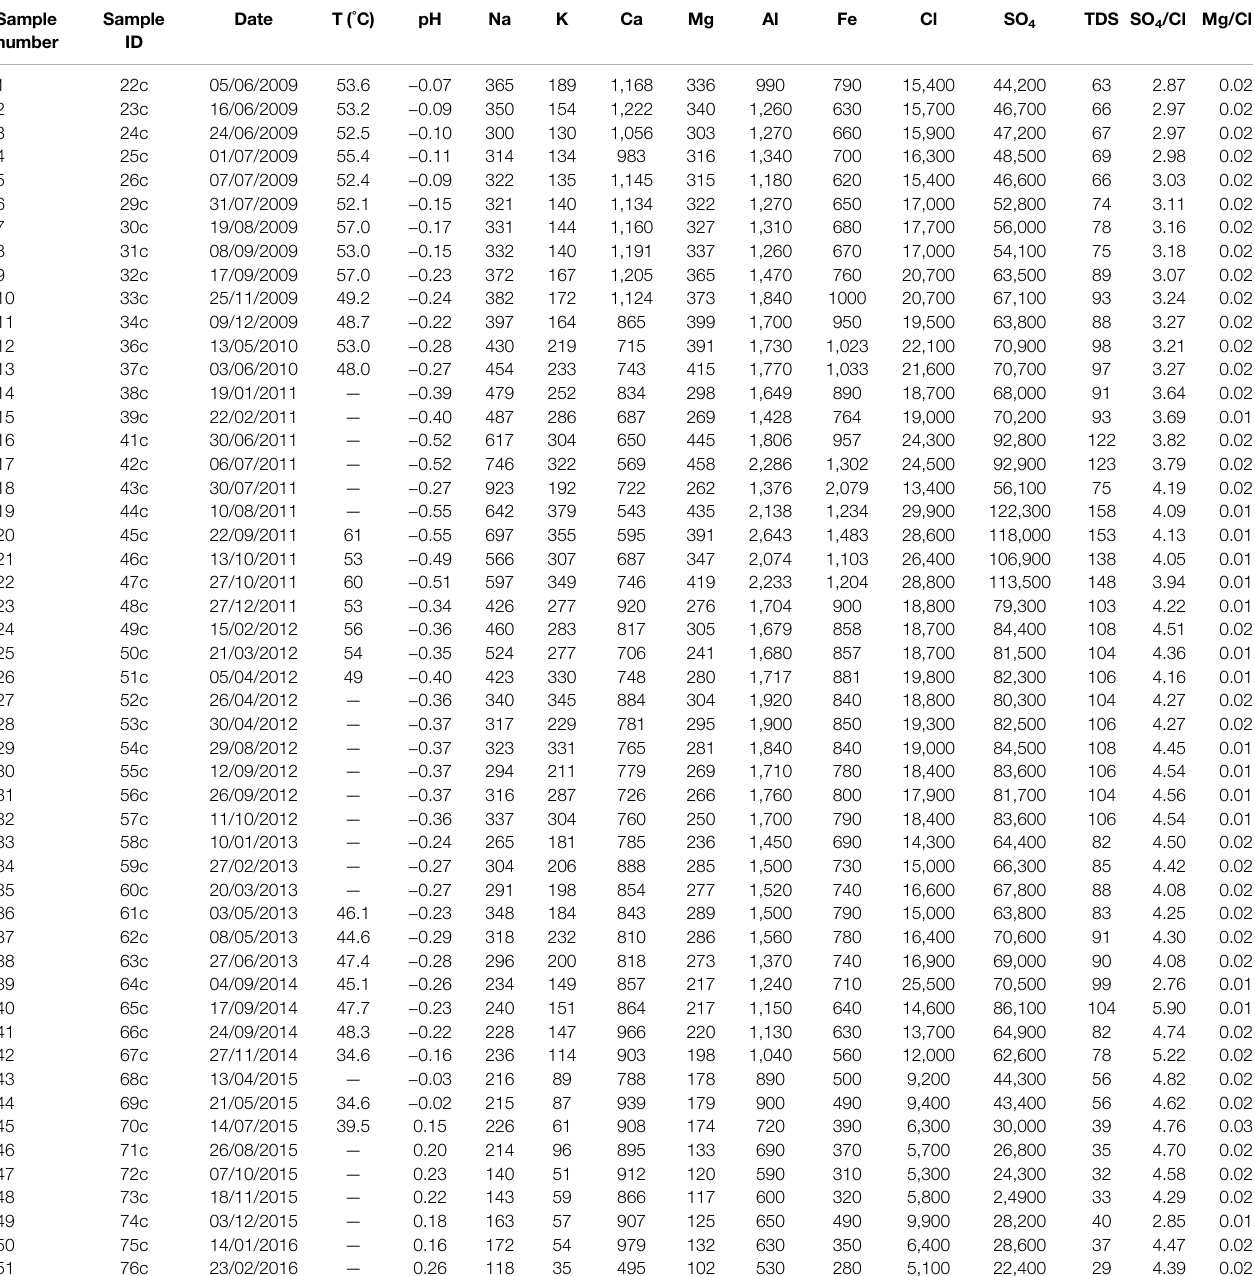
TABLE 1 | Major elements concentrations (mg L − 1 ), physico-chemical parameters, TDS (g L − 1 ) and major elements ratios (Rouwet et al., 2017, 2019). Sample